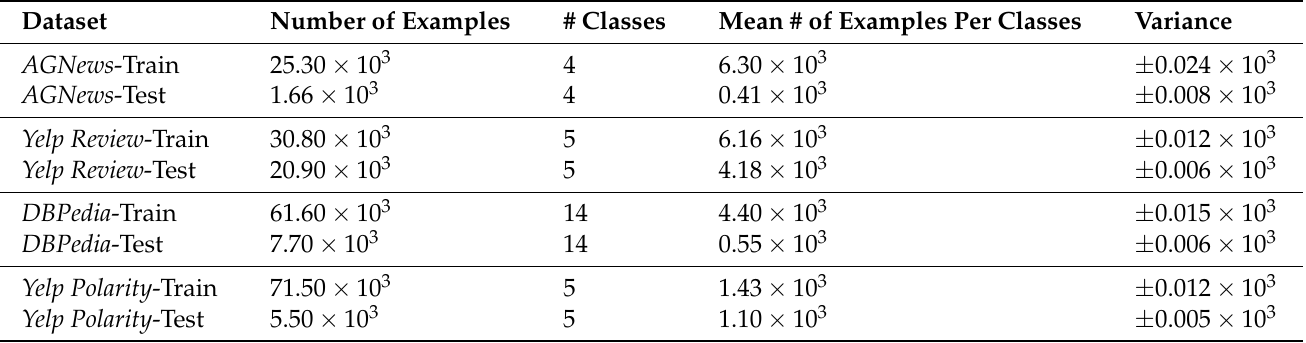
Table 1. Number of examples, number of classes, average number of examples per class, and variance distribution examples by classes in the training and testing